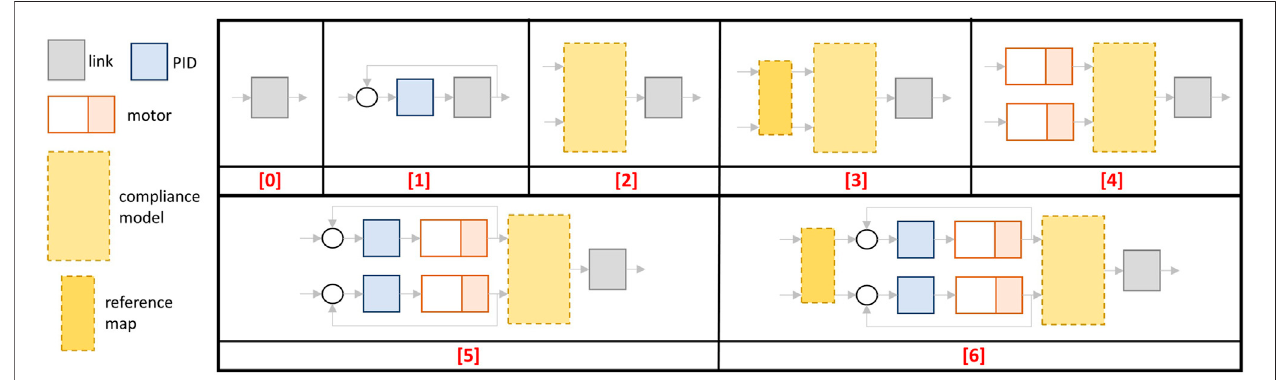
FIGURE 5 | Control schemes of the operation modes implemented in the CompliantActuatorPlugin